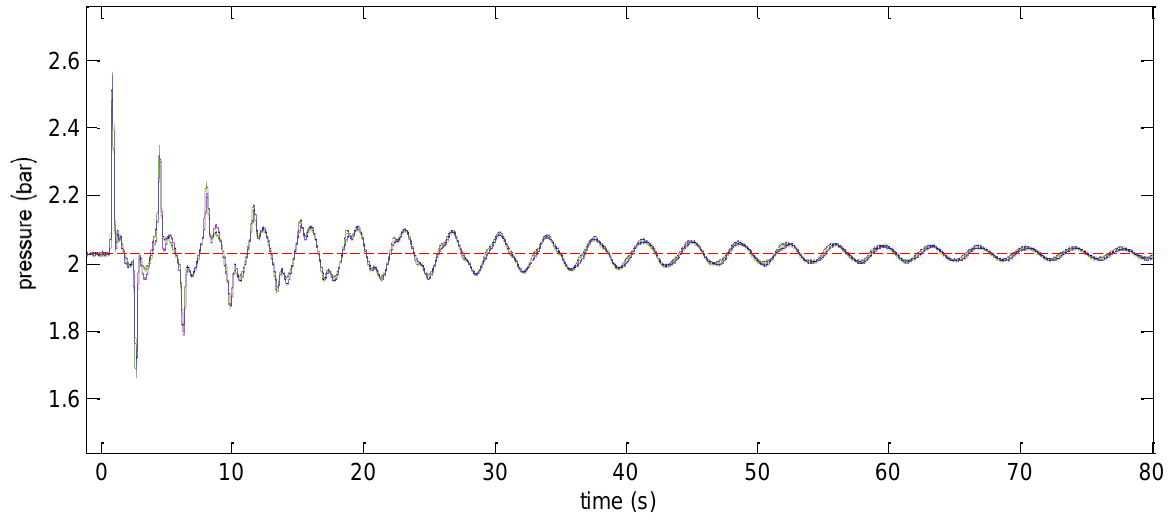
Fig 11. Pressure measured by transducer p